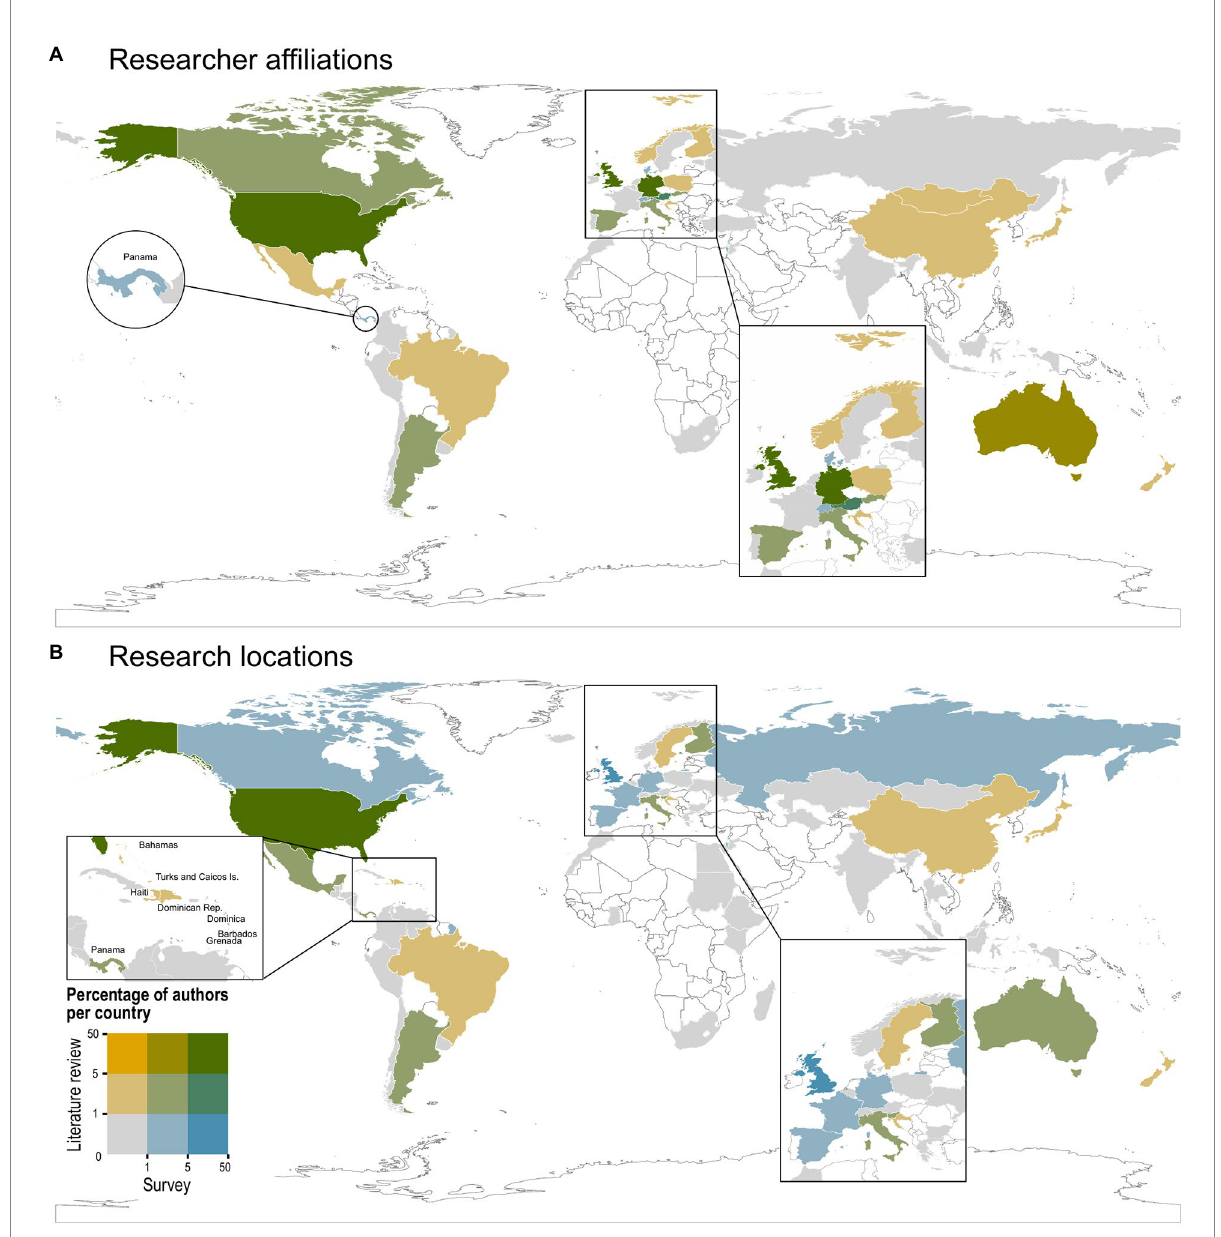
FIGURE 3 (A) Map of countries in which survey participants who self-identified as conservation paleobiologists were based, compared with author affiliations in the literature review. (B) Map of countries in which CPB research was conducted in the survey and literature review. Colors correspond with the proportional representation of authors per country in the survey versus the literature review, discretized into nine bins. Countries shown in white were not represented in either the survey or literature review. CPB is predominantly conducted by scientists based in the United States, Europe, and Australia, although their research spans most